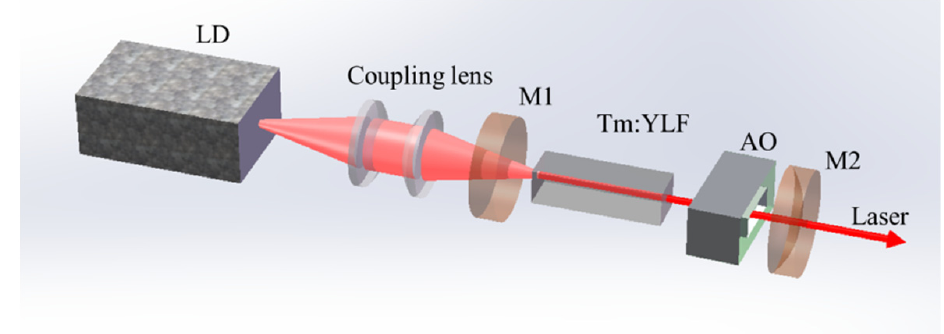
Figure 1. Experimental setup of diode-end-pumped AO Q-switched Tm:YLF laser. 3. Experimental Results